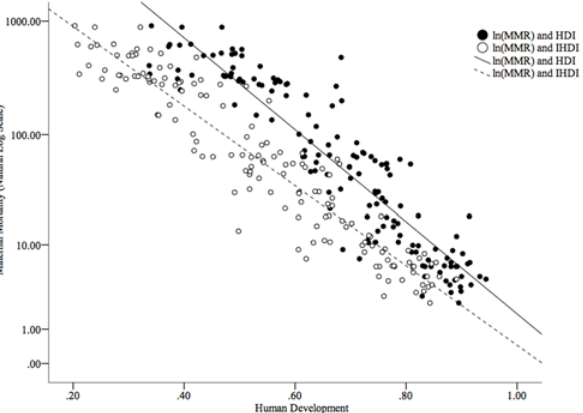
doi:10.1371/journal.pone.0140796.g005